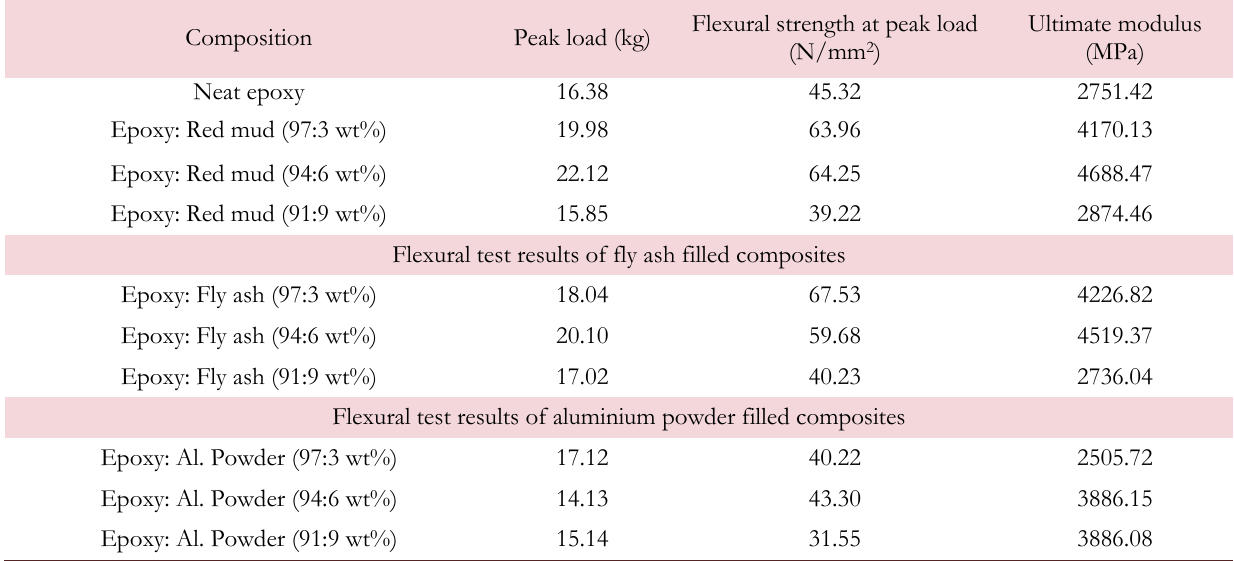
Table 6: Flexural test results of composites at different percent filler loading.